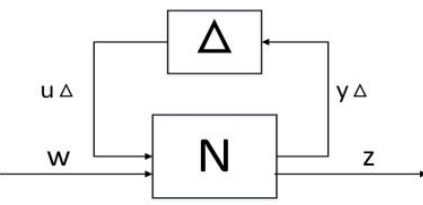
Figure 24. N ∆ structure for RP analysis.